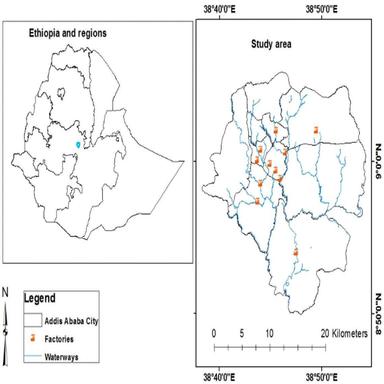
ArcMap of the National Alcohol and Liquor Factory and other potable alcohol industries that are located near rivers in Addis Ababa city, Ethiopia.